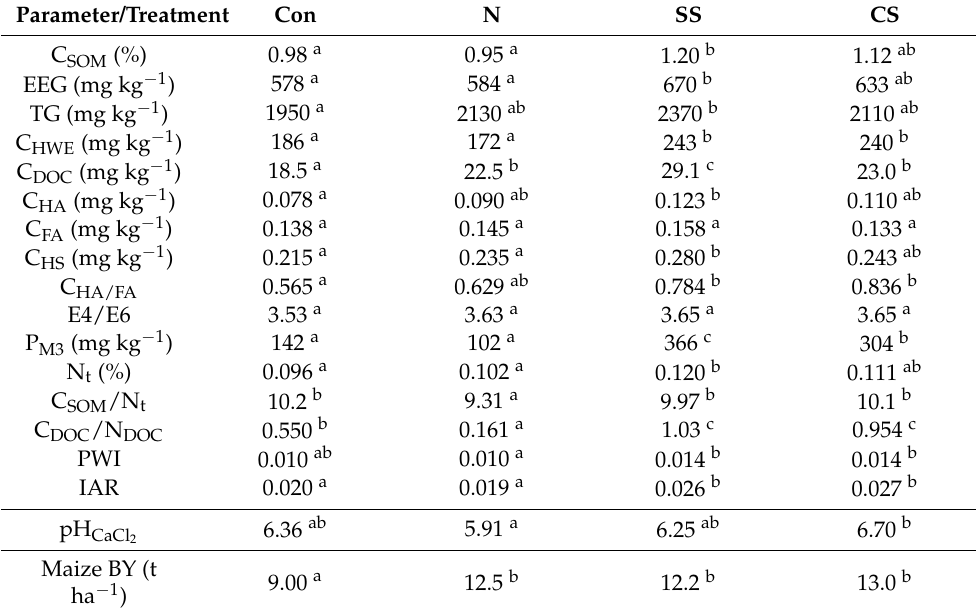
Table 5. Qualitative and qualitative parameters of soil organic matter (SOM); soil pH values and maize dry biomass yield (BY).